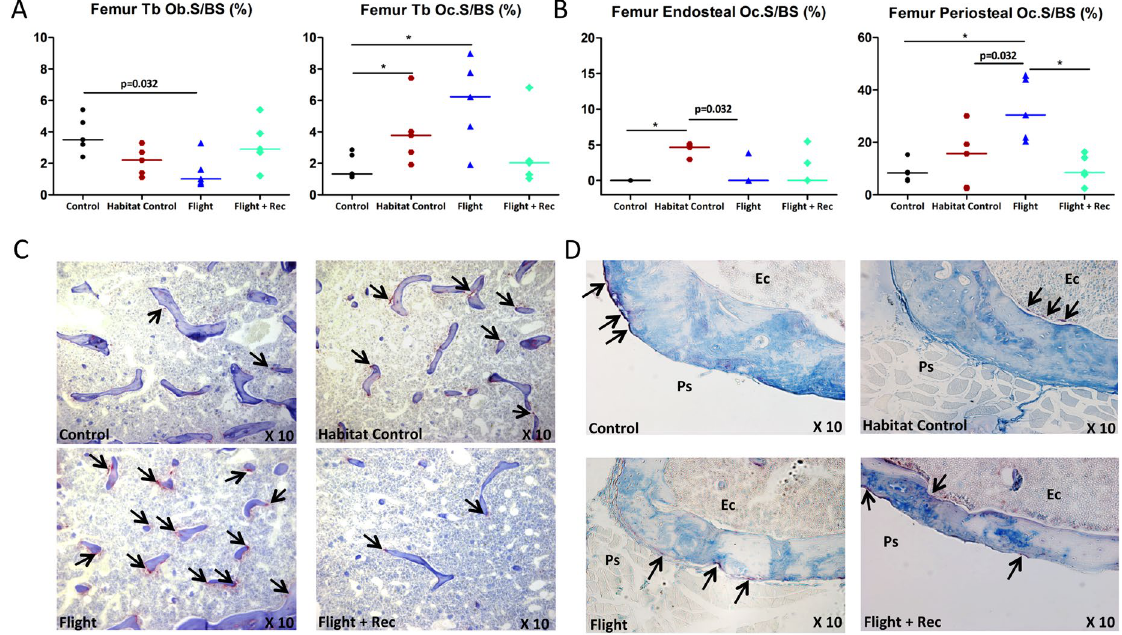
Figure 5. Effect of spacecraft housing conditions, spaceflight and recovery on ( A ) femur trabecular osteoblast surfaces (Ob.S/BS) and osteoclast surfaces (Oc.S/BS), and ( B ) cortical osteoclast surfaces. Tartrate resistant acid phosphatase staining of osteoclastic cells (black arrows) in the trabecular compartment ( C ), in the endocortical surface (Ec) and in the periosteal surface (Ps) ( D ). Data are presented as clusters of individual points (bars = median). p < 0.017, ** p <